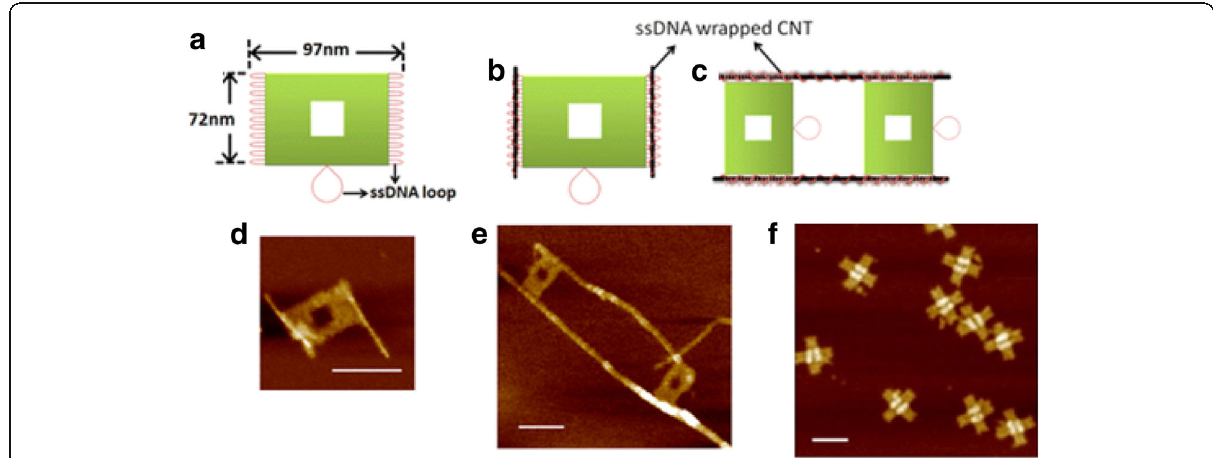
Fig. 41 Schematics of a rectangular DNA-origami. Adapted from [276]. b , c Site-specific immobilization of ssDNA-wrapped short and long CNTs onto the single rectangular DNA-origami scaffold. Adapted from [276]. d AFM images of DNA origami-nanotubes formed using self-assembly showing CNTs aligned at the edges. Adapted from [276]. e AFM images of DNA origami-nanotubes formed using self-assembly showing two single rectangular DNA- origamis aligning two long 6,5-SWCNTs. Adapted from [276]. f Cross-shaped SWCNTs. Scale bar equals 100 nm. Adapted from